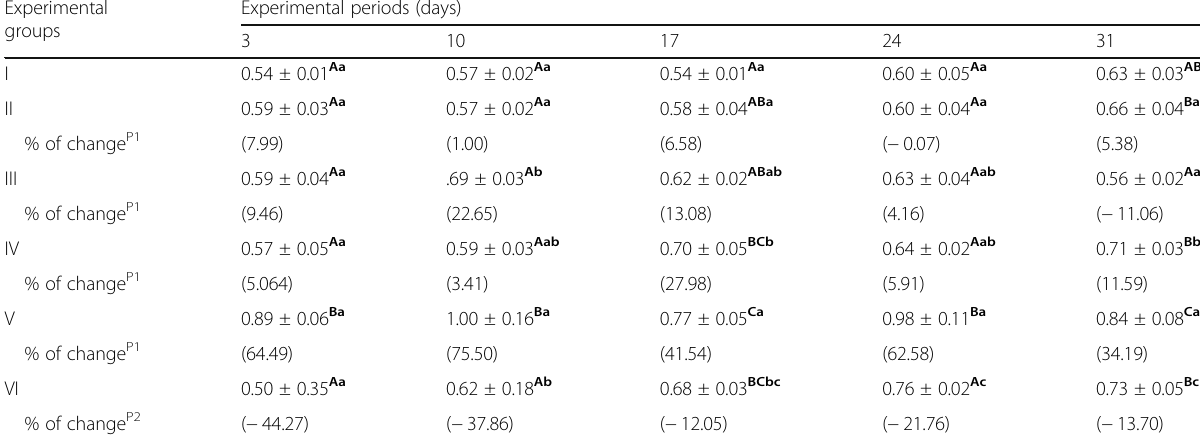
Table 5 Granulocyte count (10 9 /L) in the experimental groups at the experimental periods Experimental groups